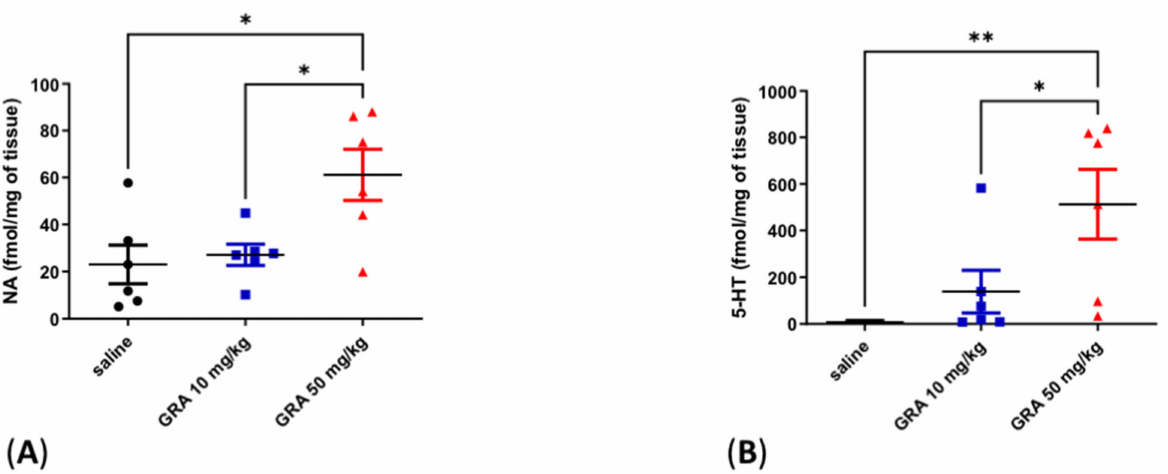
Figure 2. Effect of GRA administration on cortical monoamine quantifications in naïve rats. Effect of GRA administration on cortical NA ( A ) and 5-HT ( B ) (n = 6 per group) in rats treated (i.p.) with saline (black dots), GRA 10 mg/kg (blue dots) and GRA 50 mg/kg (red dots). * p < 0.05, ** p < 0.01 GRA 50 mg/Kg vs. saline. * p < 0.05, GRA 50 mg/kg vs. GRA 10 mg/kg. One-way ANOVA followed by Tukey’s post hoc